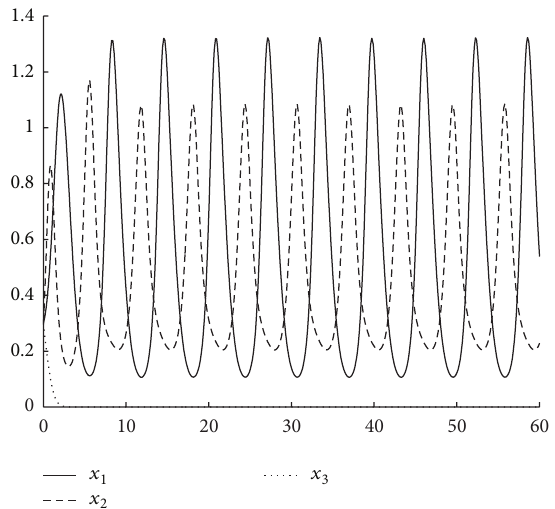
Figure 2: Dynamic behaviors of system (62). Here, we take the initial conditions 𝑥 1 (𝜃) ≡ 𝑥 2 (𝜃) ≡ 𝑥 3 (𝜃) ≡ 𝑢 1 (𝜃) ≡ 𝑢 2 (𝜃) ≡ 𝑢 2 (𝜃) = 0.3 for all 𝜃 ∈ (−∞,0] .